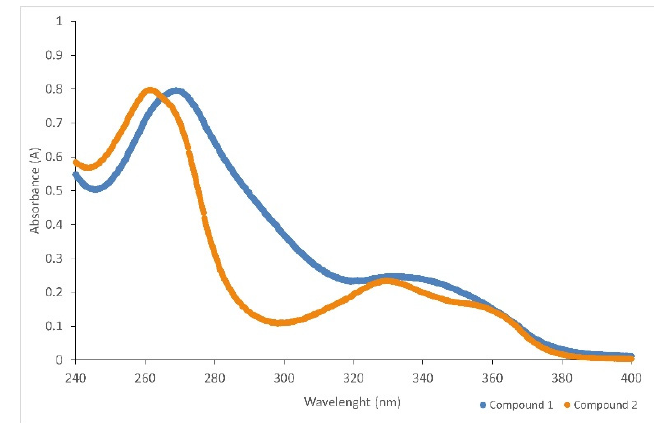
Figure 13. The absorption spectrum of compound I and II .